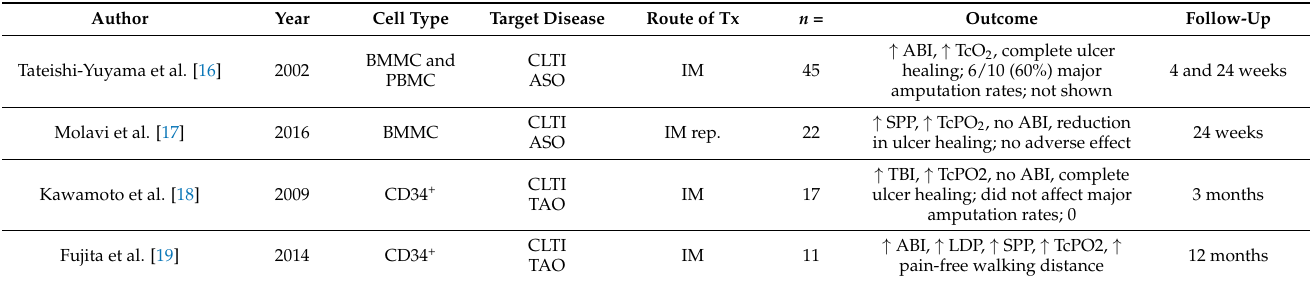
Table 1. Positive stem cell-based trial outcomes in patients with CLI.